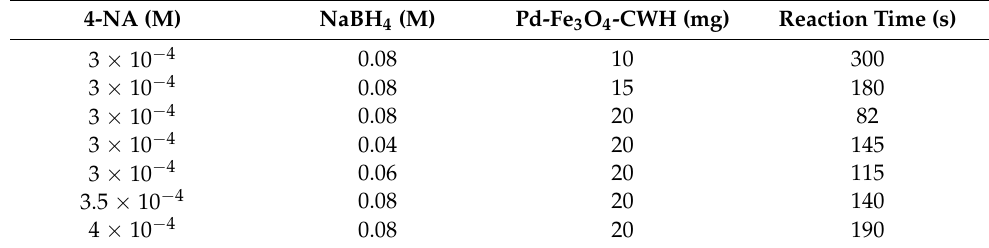
Table 1. The optimization of reaction parameters for 4-NA reduction.